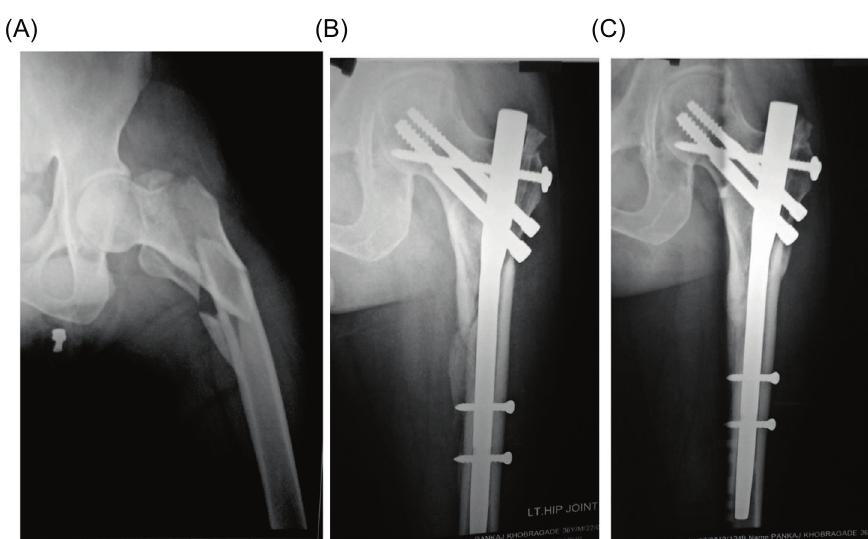
Figure 1. A 72-year-old female patient with a type 31-A3.3 fracture. (A) Preoperative Initial radiograph. (B) Radiograph of the proximal femur at the 6th postoperative week with additional screw with washer. (C) Radiograph of the proximal femur at the 12th postoperative month showing good consolidation of fracture.